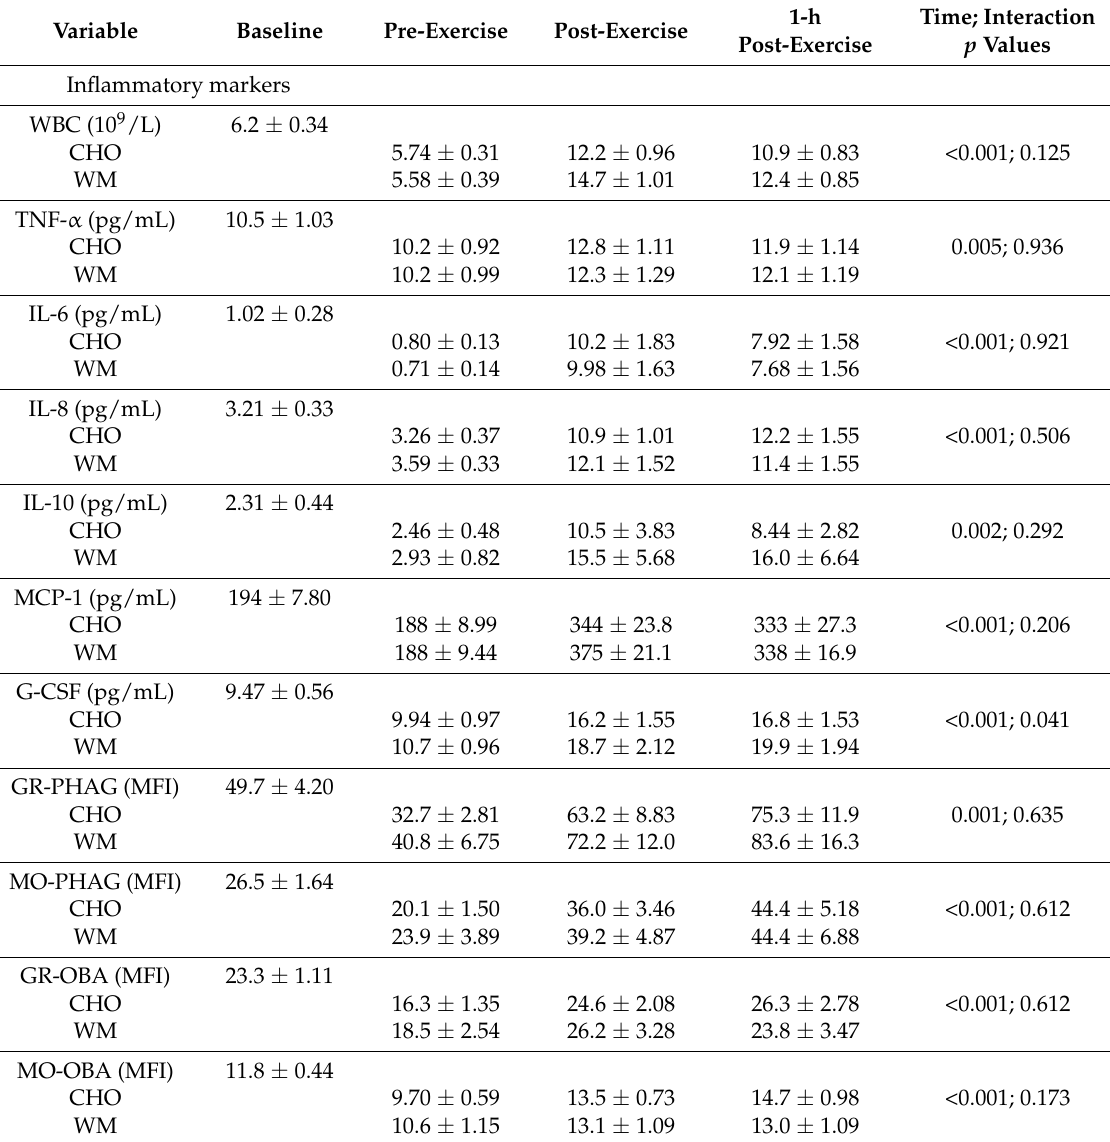
Table 2. Inflammation and immune-function